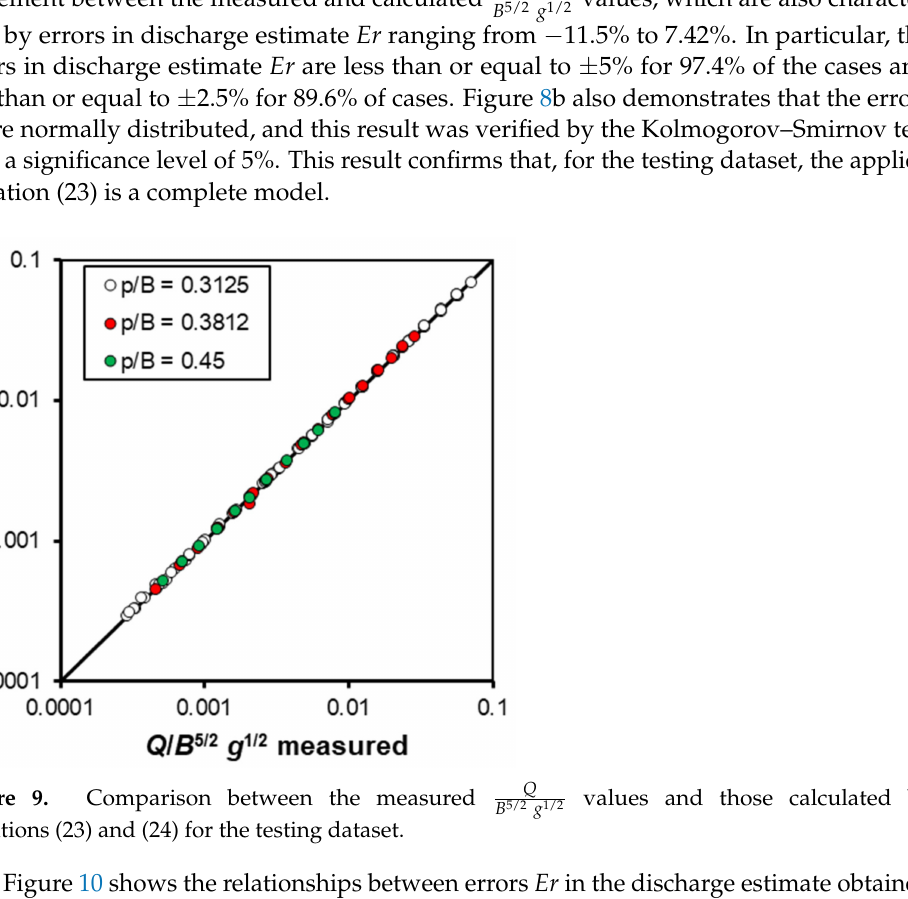
values and those calculated by B 5/2 g 1/2